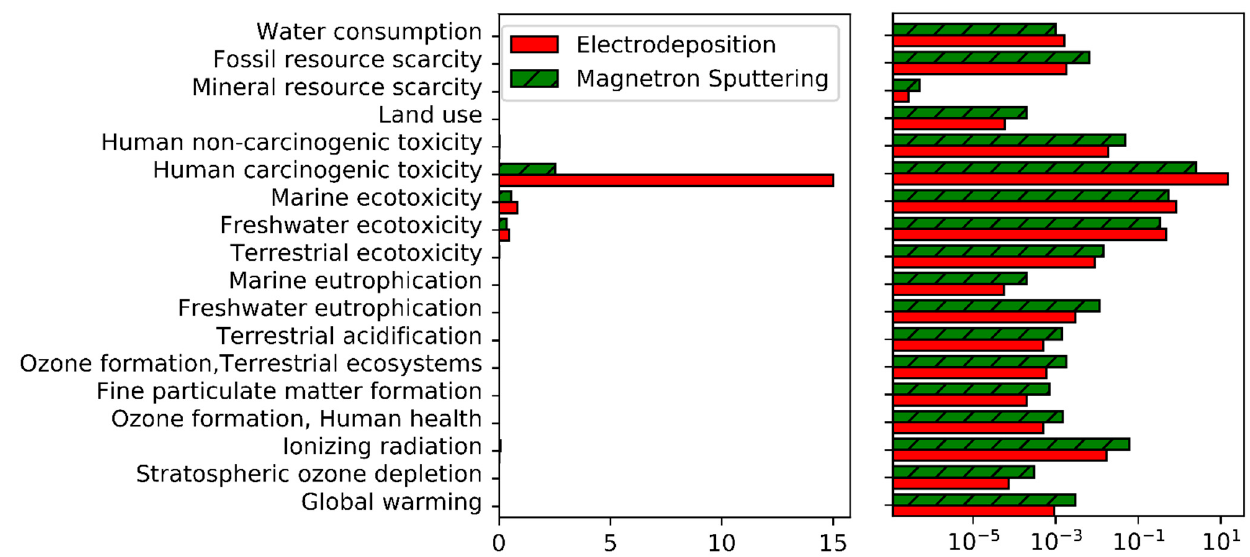
Figure 1. Normalized impacts of magnetron sputtering and electrodeposition for all impact categories. Left = linear scale, right = logarithmic scale.